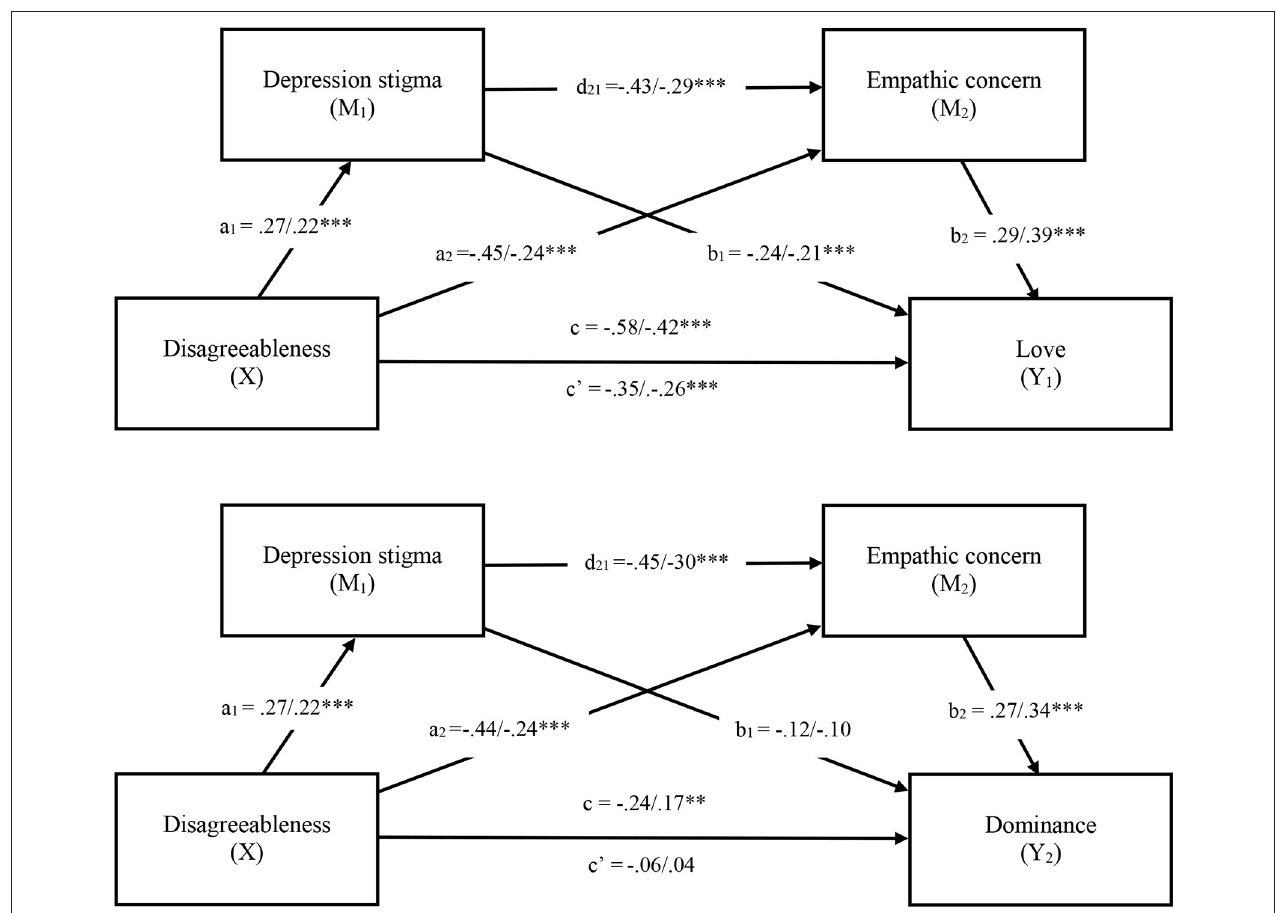
FIGURE 4 | Serial mediation models in Study 2. Note. Values shown reflect unstandardized/standardised coefficients. * p < 0.05, ** p < 0.01, *** p < 0.001. c = Total effect, c ′ = Direct effect.